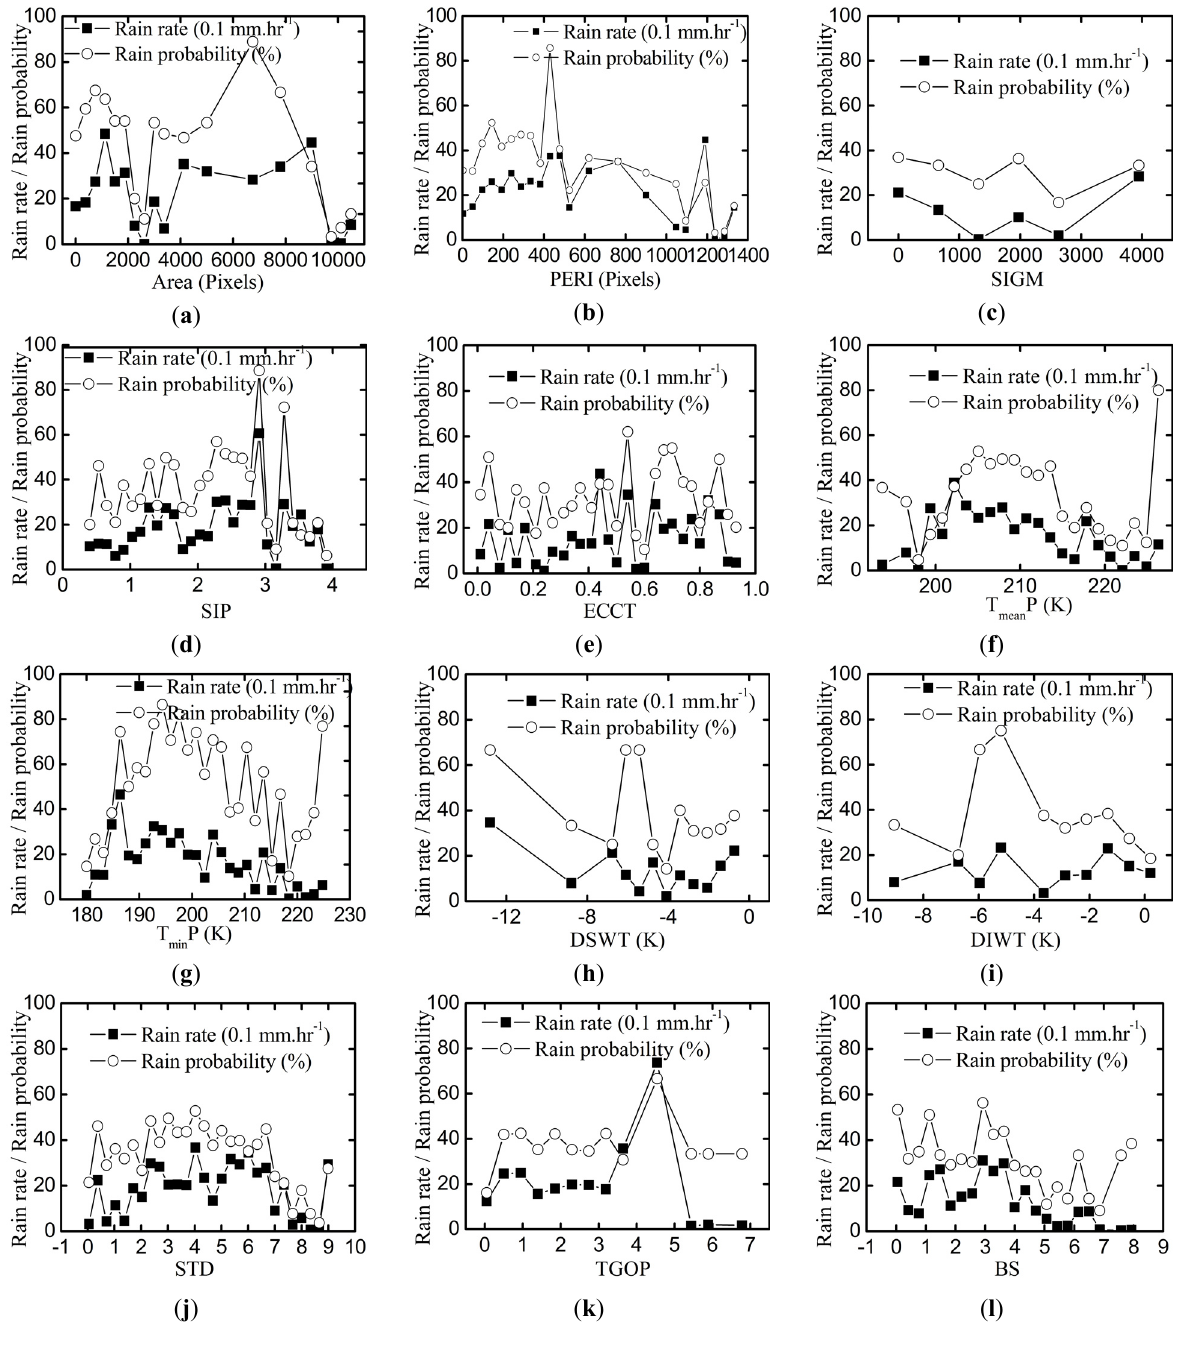
Figure 2. The relationship between the cloud patch characteristics and precipitation in the HRB. ( a ) Distribution of rain variables and cloud patch area (Area); ( b )–( l ) are the same as ( a ) but for perimeter (PERI), shape index of the geometric inertia momentum (SIGM), shape index of the perimeter (SIP), eccentricity (ECCT), mean TB of cloud patch (T P), minimum TB of cloud mean patch (T P), difference of Cb patch TB for the split window (DSWT), difference of Cb patch min TB for IR and WV channel (DIWT), standard deviations of the cloud patch (STD), TB gradient of cloud patch(TGOP), and boundary steepness (BS),